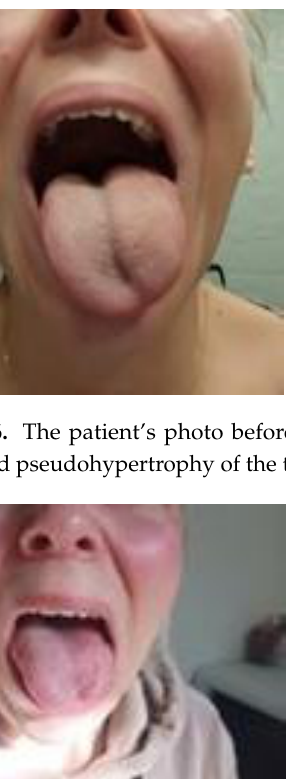
Brain Sci. 2023 , 13 , x FOR PEER REVIEW 8 of 14 Figure 5. Follow-up MRA of the head arteries: ( a ) follow-up TOF MRA at the level of the carotid canal entrance showing the resolution of the left ICA stenosis (arrow); ( b ) follow-up TOF MRA demonstrating the reduction in the size of the left ICA false aneurysm (arrow); ( c ) fat saturated T1- weighted image showing small residual intramural thrombus in the left ICA (arrow). 2.6. Neuro-Logopaedic Therapy Before starting neuro-logopaedic therapy, the Frenchay Dysarthria Assessment scale revealed the following parameters: significant weakening of the cough reflex, a slight weakening of the swallowing and salivary reflexes, and an exorbitant gag reflex. Moreo- ver, the patient had correct lip movements but experienced breathing disorders while speaking and suffered from soft palate dysfunction. Length, pitch, and strength of phona- tion were reduced to a significant extent during the above-mentioned examination. It also revealed tongue deviating to the left side with significant limitation of lateral and upward mobility. In addition, it presented atrophy of the tongue and moderate impairment of spontaneous speech. As part of the therapy, we provided the patient with a special neurological massage of the sublingual muscles once a week. The stimulation started with the muscles located in the front part of the oral cavity. Then, after the gag reflex was reduced, the massage of the sublingual muscles located at the root of the tongue followed. As a result, the patient experienced an improvement in the clarity of spontaneous